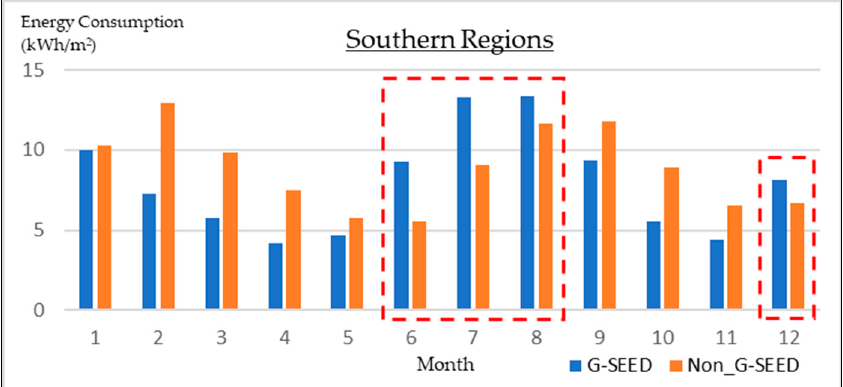
Figure 7. Bar chart of the monthly energy consumption of the court house buildings in the southern region based on G-SEED certification.